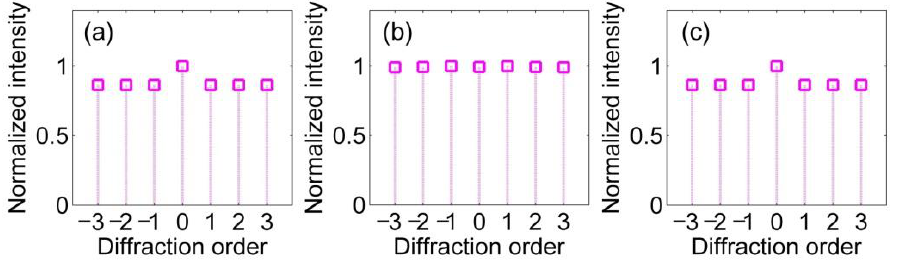
Figure 5. Simulated reconstructed intensity distribution of the traditional 0-π DOE for 1 × 7 beam splitting with etching depth of ( a ) 562 nm; ( b ) 712 nm; ( c ) 762 nm.